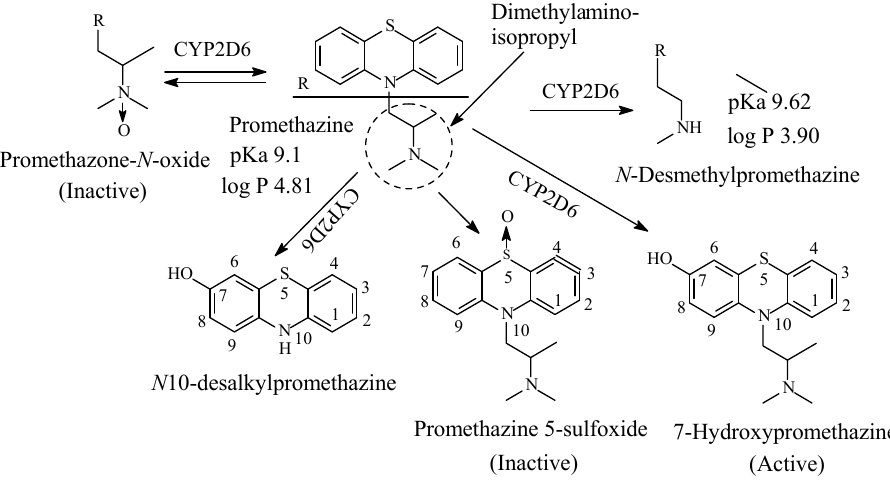
Figure 24. Metabolic pathways of promethazine.